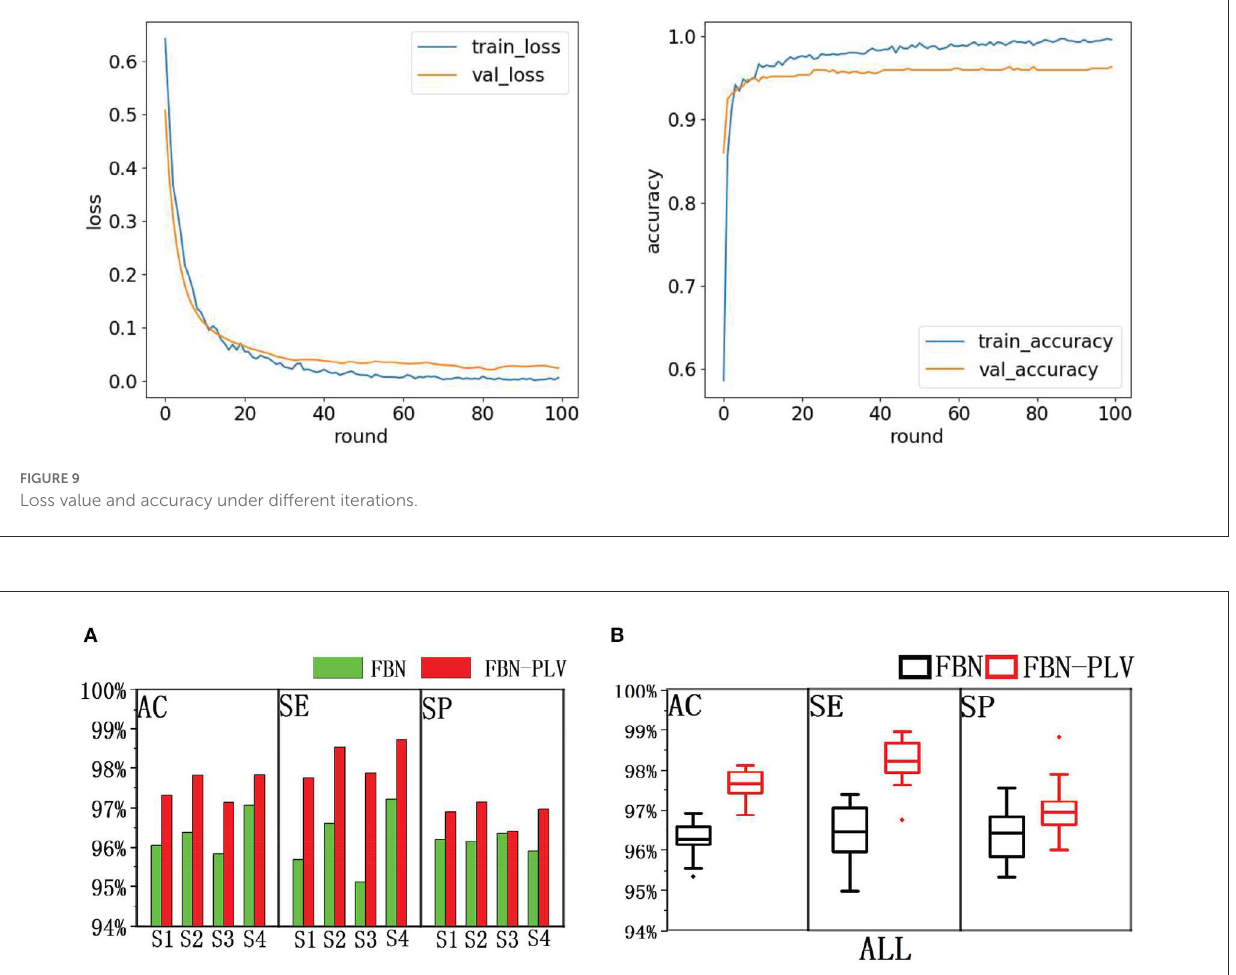
FIGURE10 The performance comparison between FBN and FBN-PLV models. (A) AC, SE, and SP of the actual EEG data of each patient after using the method of this paper. (B) AC, SE, SP after synthesis of actual EEG data for all